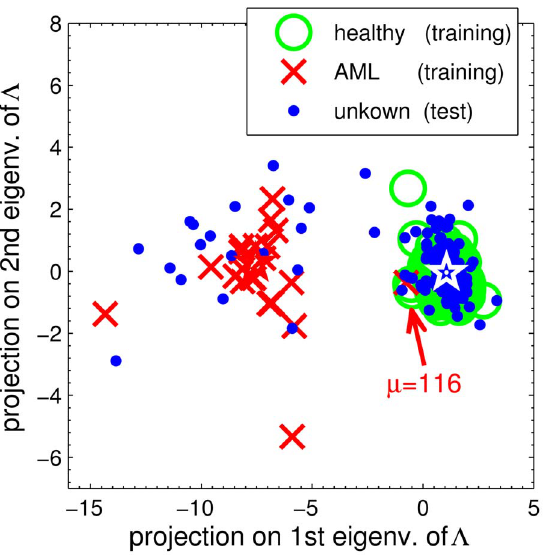
Figure 6. Visualization of the data set as obtained by GMLVQ. Projections of normalized feature vectors on the leading eigenvectors of L are displayed. Green circles correspond to healthy donors, red symbols mark AML patients in the training set, while blue dots represent test set data. Stars indicate the positions of the prototypes. The red arrow marks patient m ~ 116 in the training set, who is labeled as AML but is misclassified persistently for a large range of thresholds H , cf. Eq. (5).